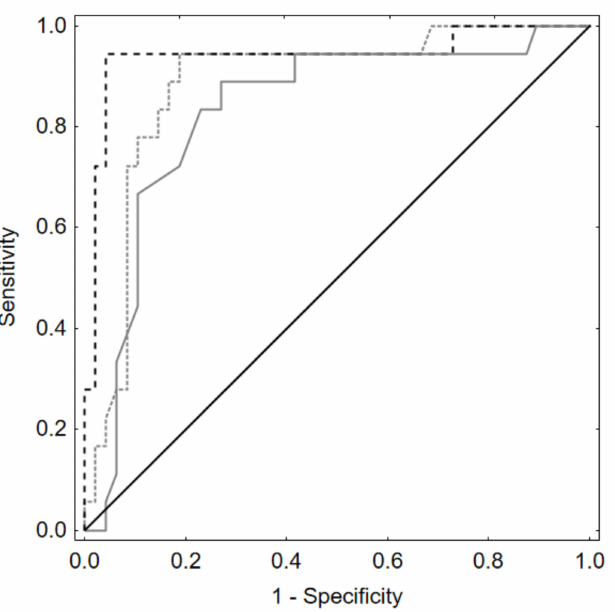
Figure 7. ROC curves based on backward stepwise logistic regression models. Prediction of late recanalization by neck size, packing density, and 1st VPD. 1st VPD—dashed line. Aneurysm neck size alone—solid line. Packing density—line